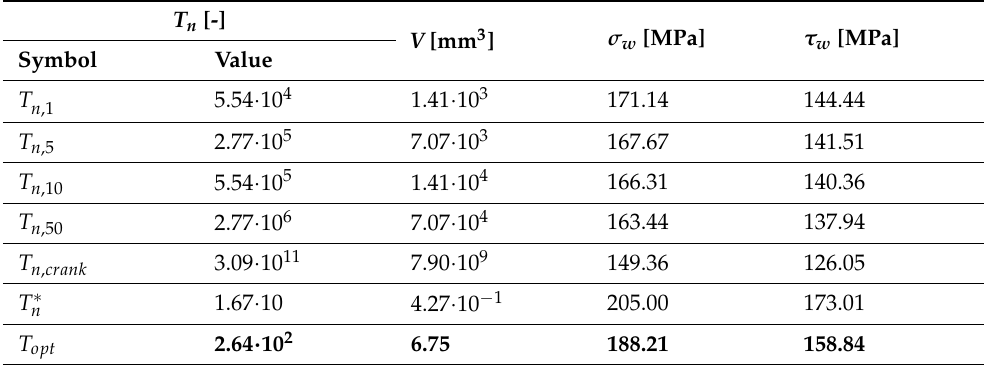
Table 3. Return period, prediction volume and fatigue limits for EN-GJS-400-18